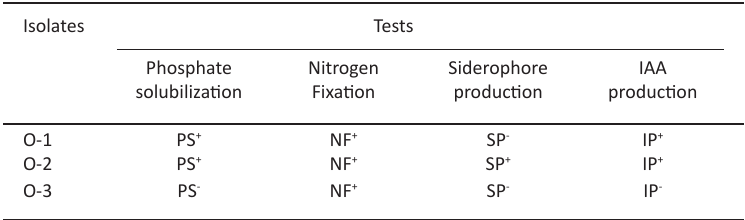
Table 2. Result for in-vitro plant growth promoting activity